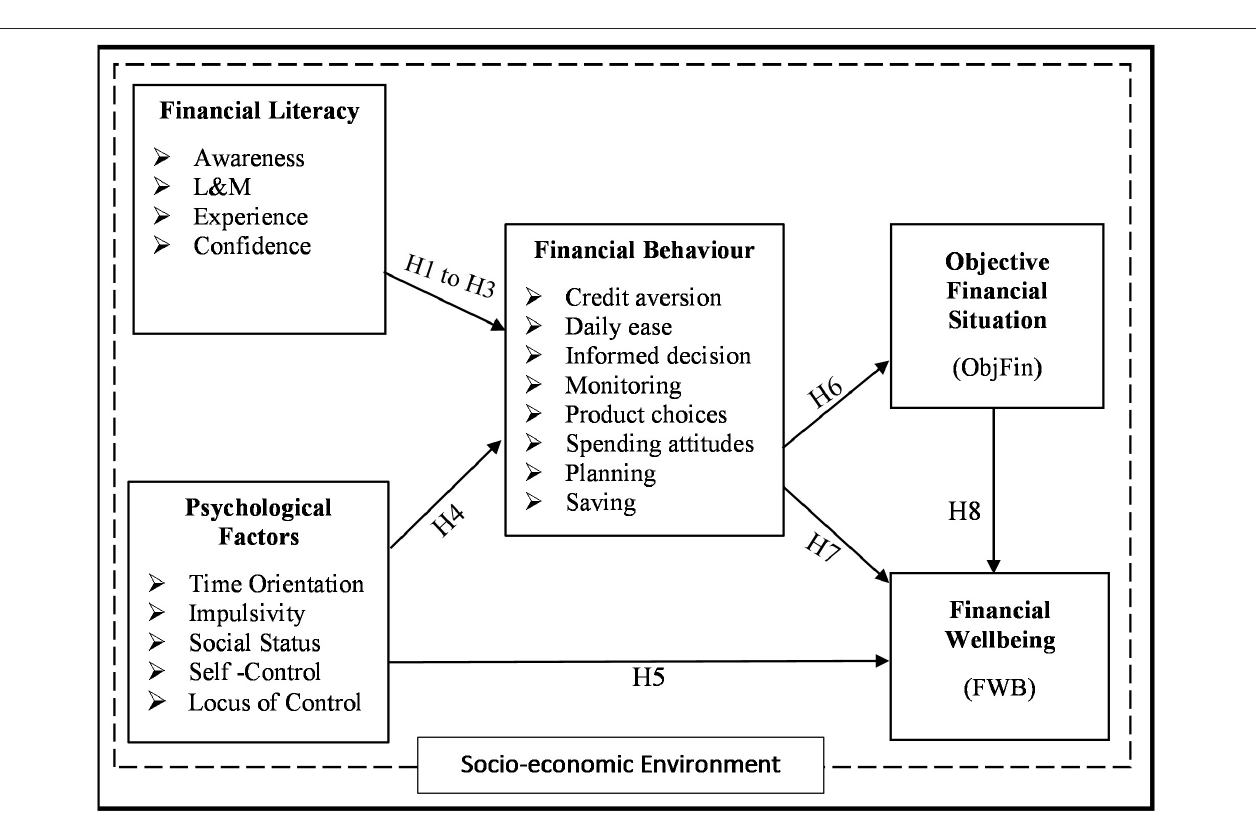
FIGURE 2 | Conceptual Model. Source: Self depiction, L&M, Objective financial